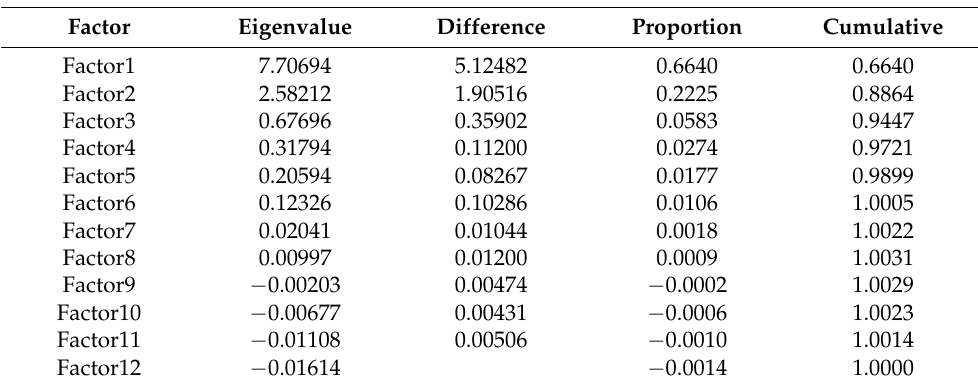
Table 2. The results of factor analysis of the main components for estimating the sustainability index for public health.